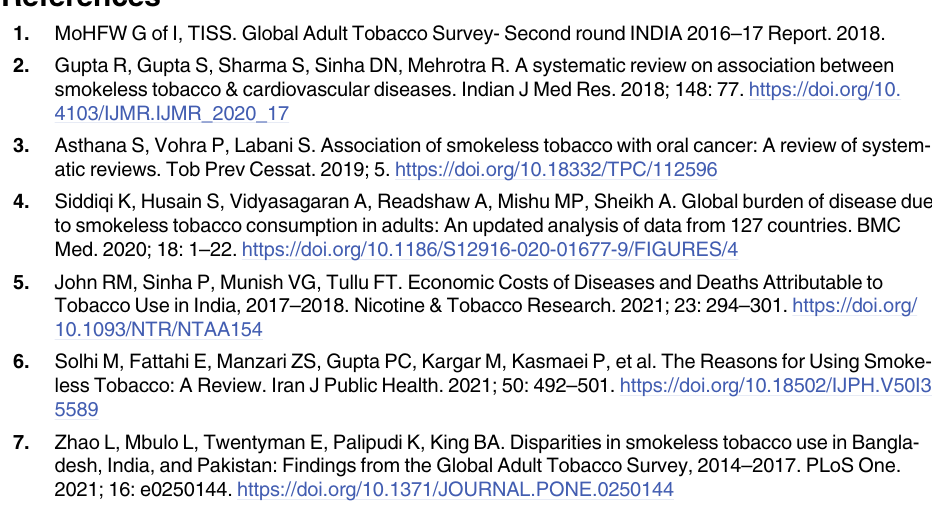
S3 Table. State-wise quantity and amount worth of gutka seized.